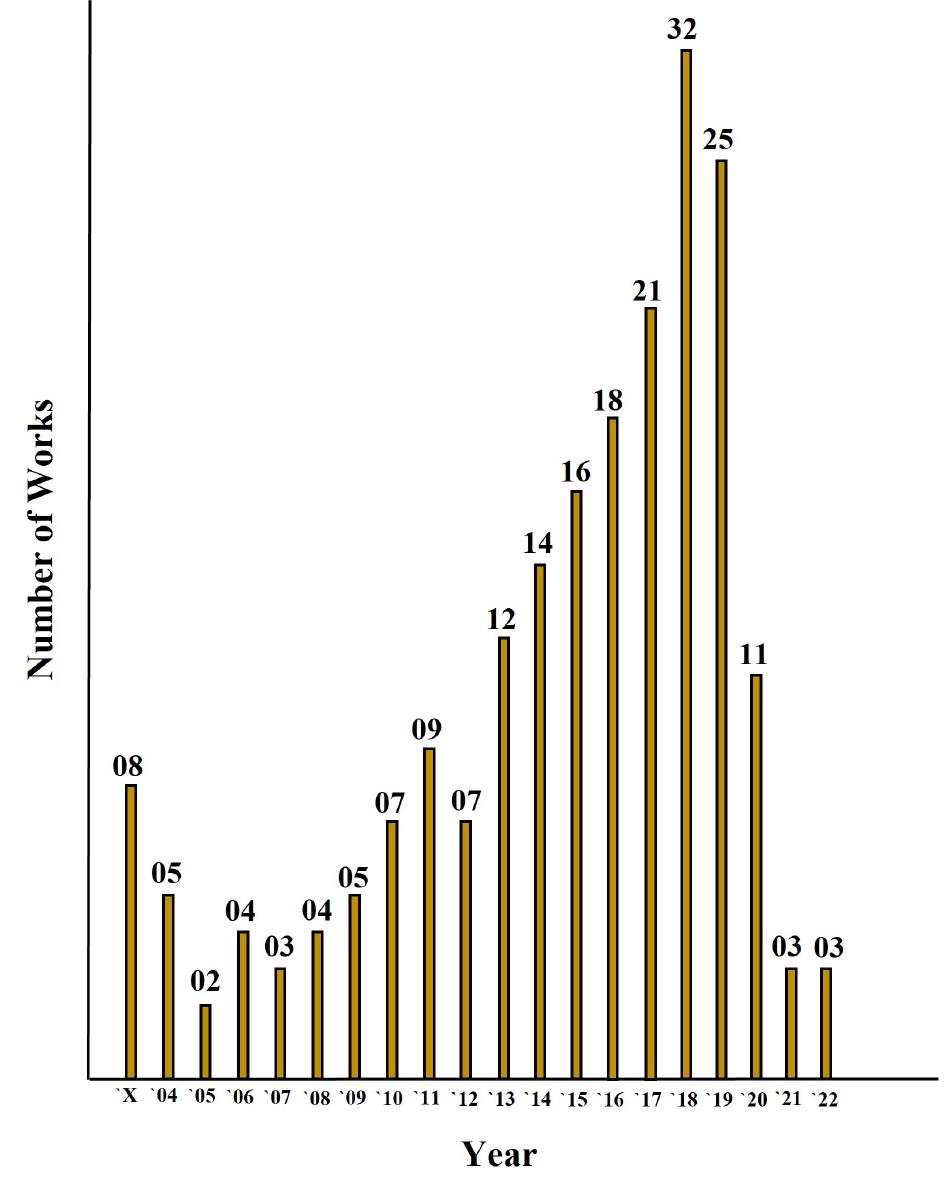
Figure 3. The number of works considered in this work, shown according to the publication year. ‘X represents year 2003 and